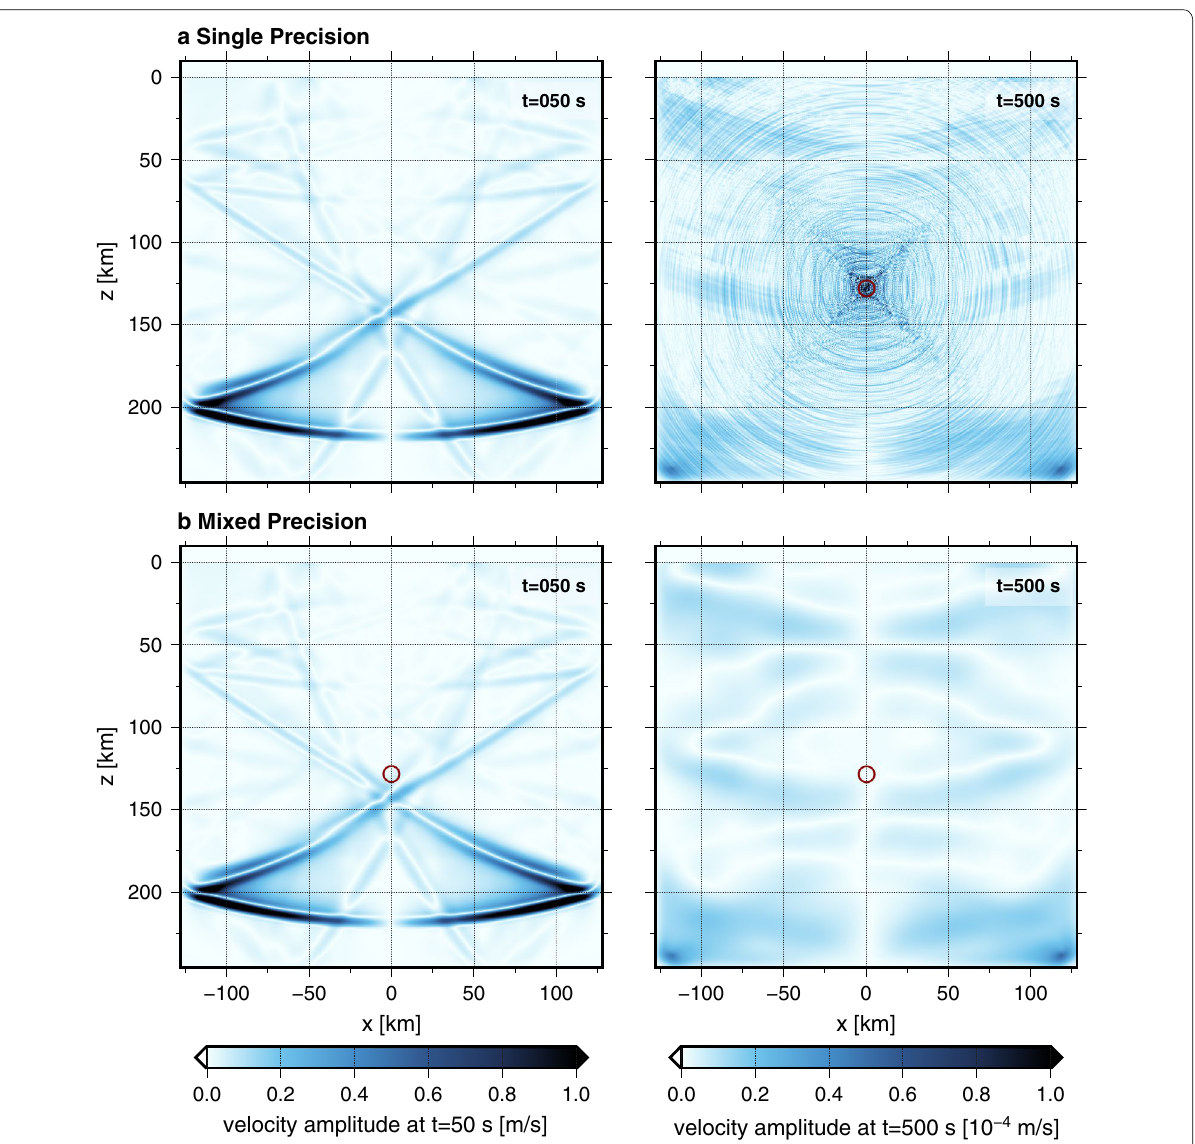
Fig. 6 A comparison of simulations based on a single-precision arithmetic calculations and b mixed-precision calculations. In each frame, the absolute amplitude of the horizontal components of the velocity at the elapsed times of 50 and 500 s are shown in the color scales . Circles show the location of the point source, which is an isotropic radiation of seismic